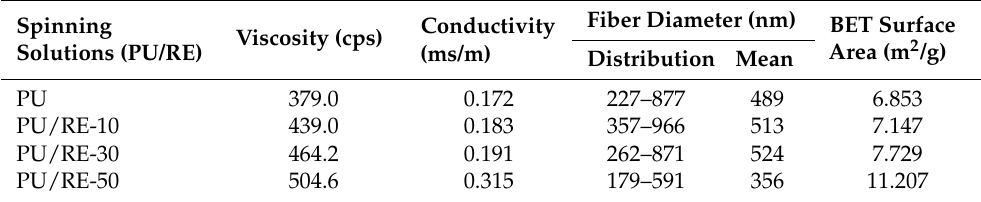
Table 1. Physical properties of polyurethane/rare earth (PU/RE) spinning